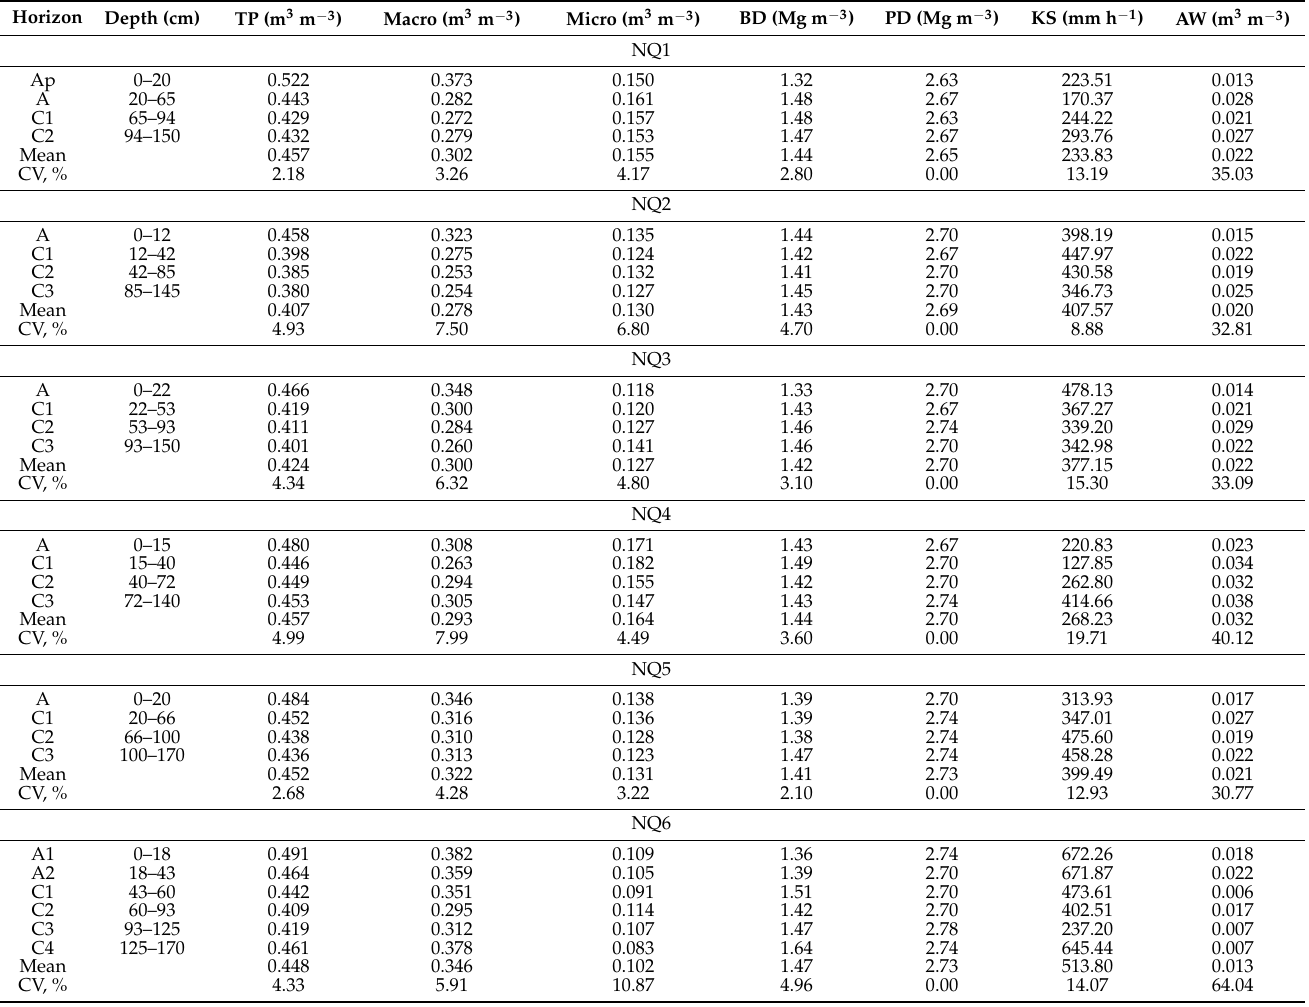
Table 4. Mean values of physical–hydric properties of Quartzipsamments profiles of the Southwest of Rio Grande do Sul State, southern